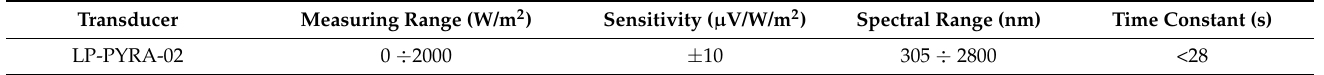
Figure 7. Pyranometer ( a ), anemometer ( b ), and humidity sensor ( c ). Table 1. Technical specifications of the pyranometer.